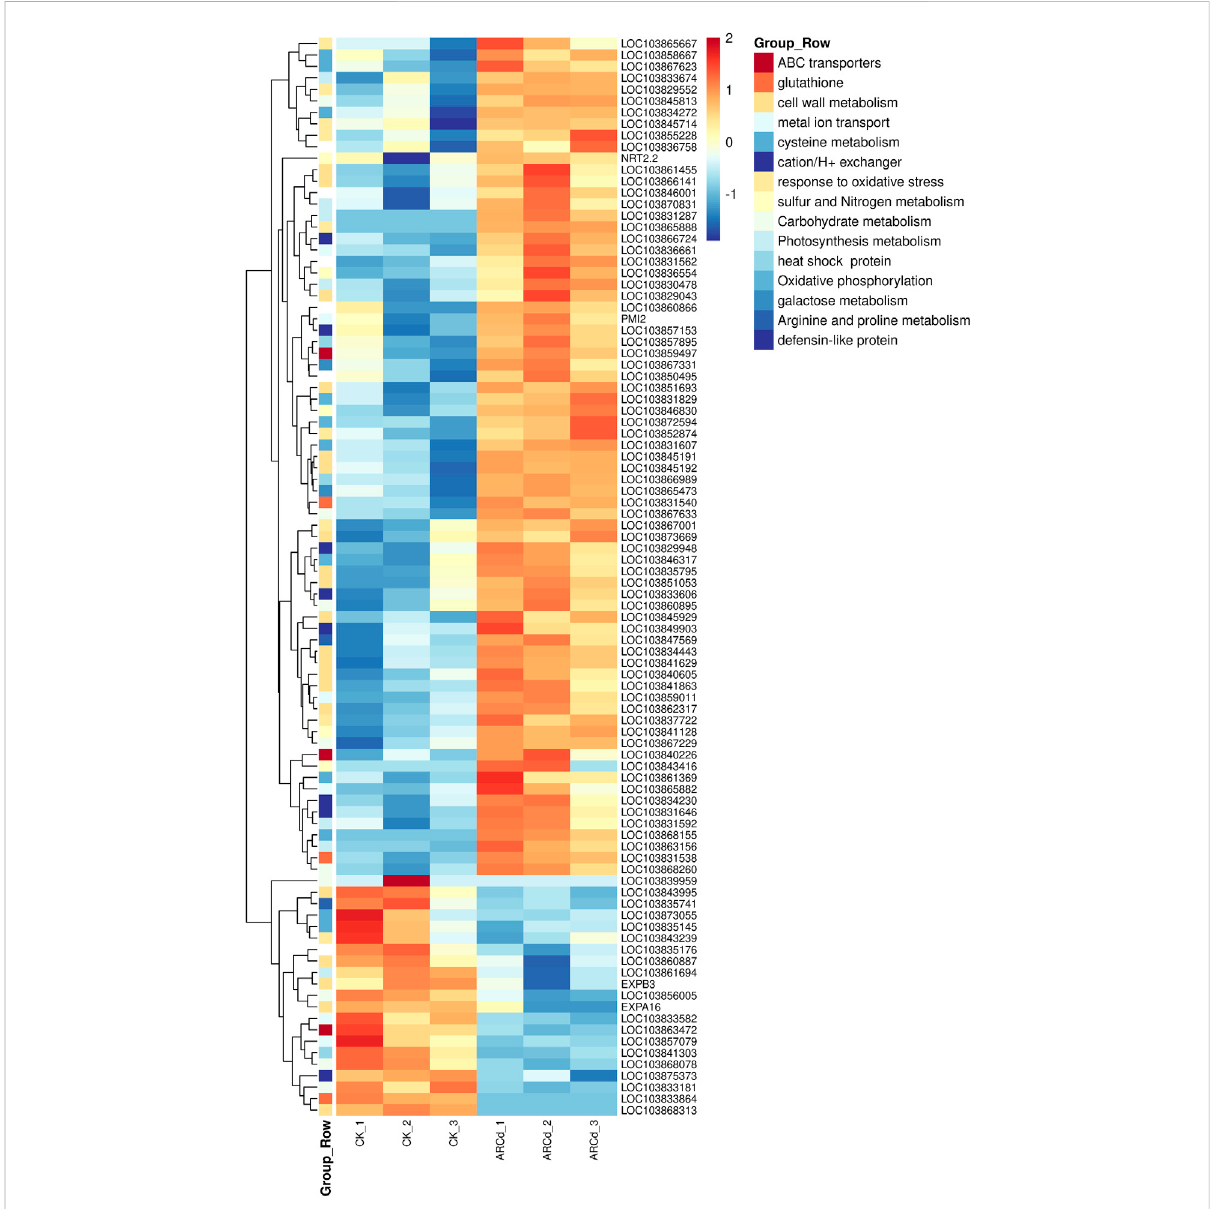
FIGURE 9 Heat maps represented the log2-fold change in the expression of DEGs (red is upregulated and blue is downregulated) related to some important genes between the control and AR-Cd-treated